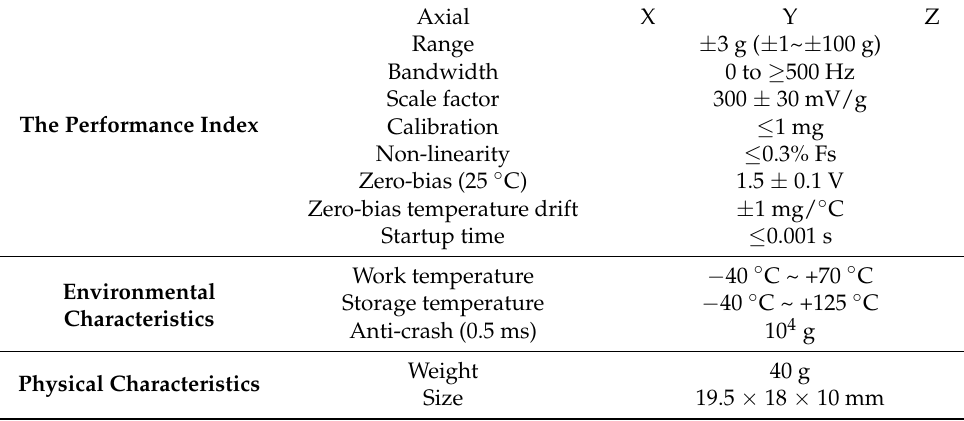
Table 5. Characteristics of the accelerometer